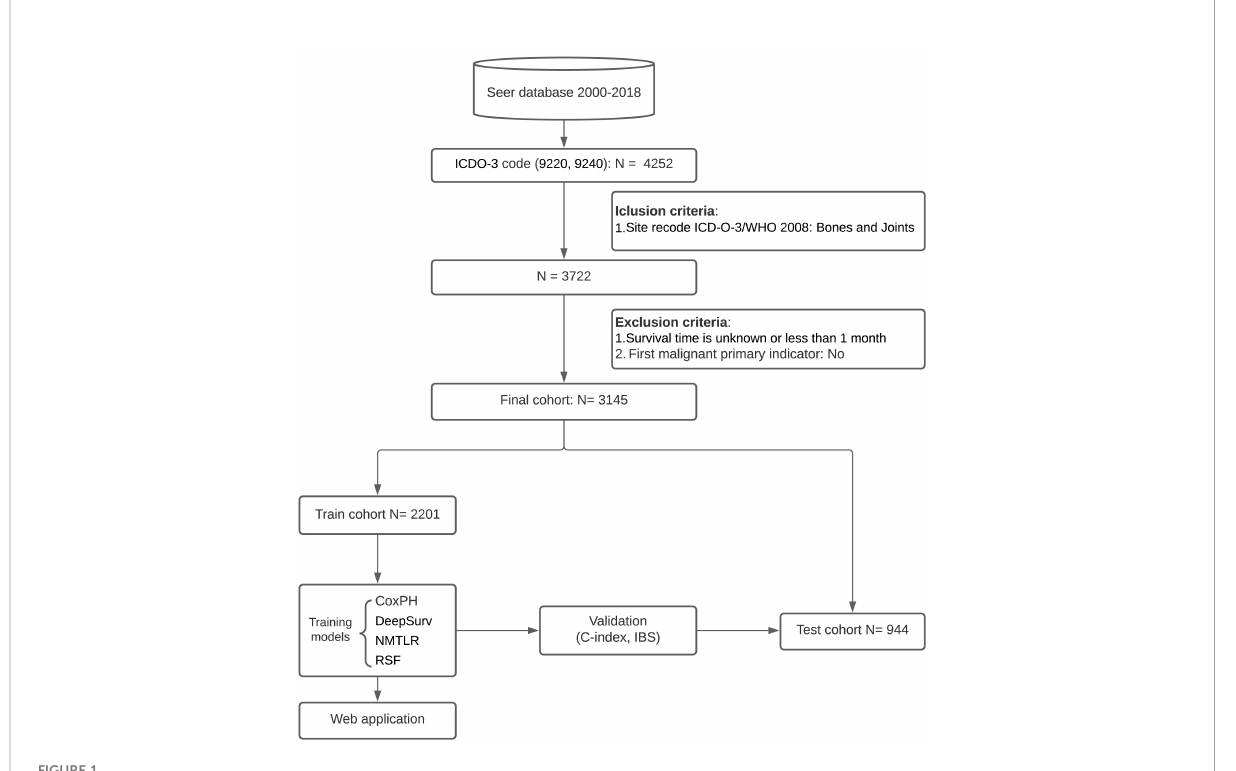
FIGURE 1 Study pro fi le and analysis